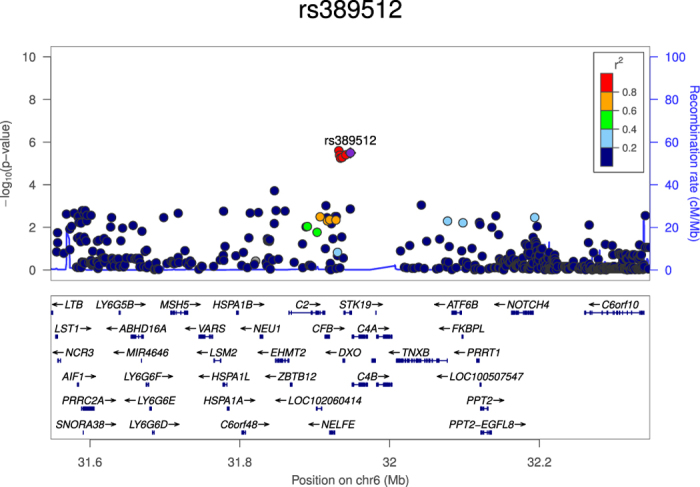
Regional plot for SNP rs389512.